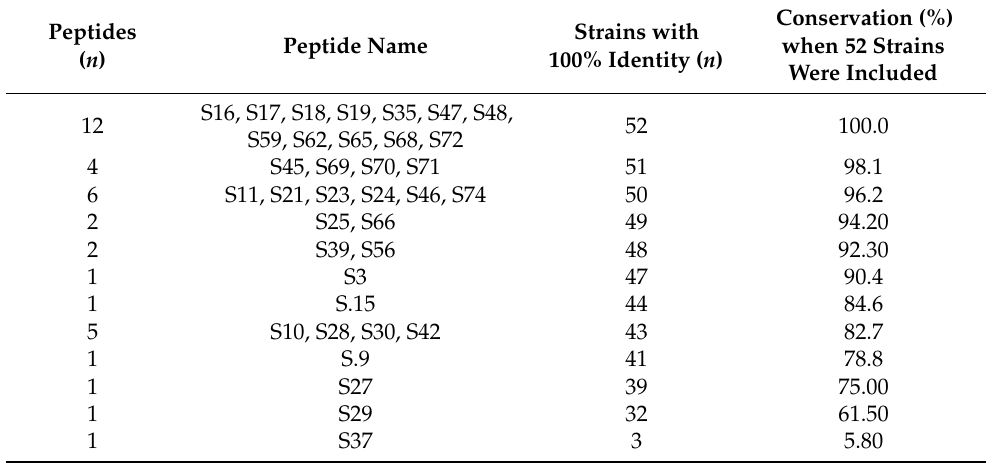
Table 1. Conservation analysis of SARS-CoV-2 S protein peptides recognized by vaccinated and COVID-19 convalescent sera.